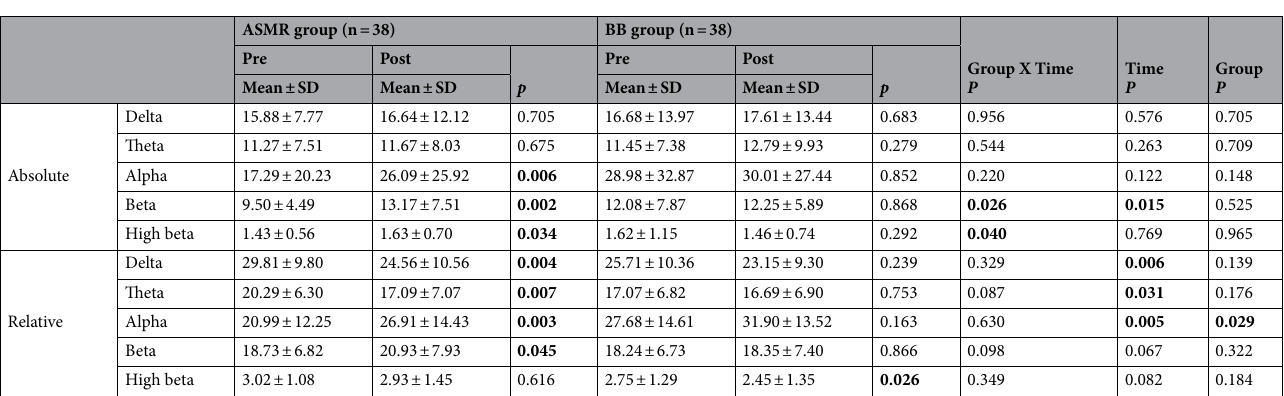
Table 3. Band power comparison of before and after application use measured by quantified electroencephalogram. Significant values are in bold. Paired t-test was performed to examine within-group differences. Cohen’s d was calculated to estimate the effect size. Repeated measures analysis of variance (RM ANOVA) was used to examine group-by-time interaction. ASMR : Autonomous sensory meridian response, BB : Binaural